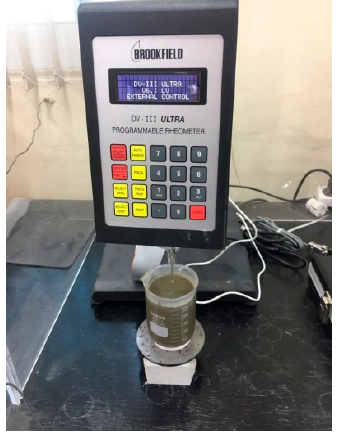
Figure 2. Test setup to measure gel time.